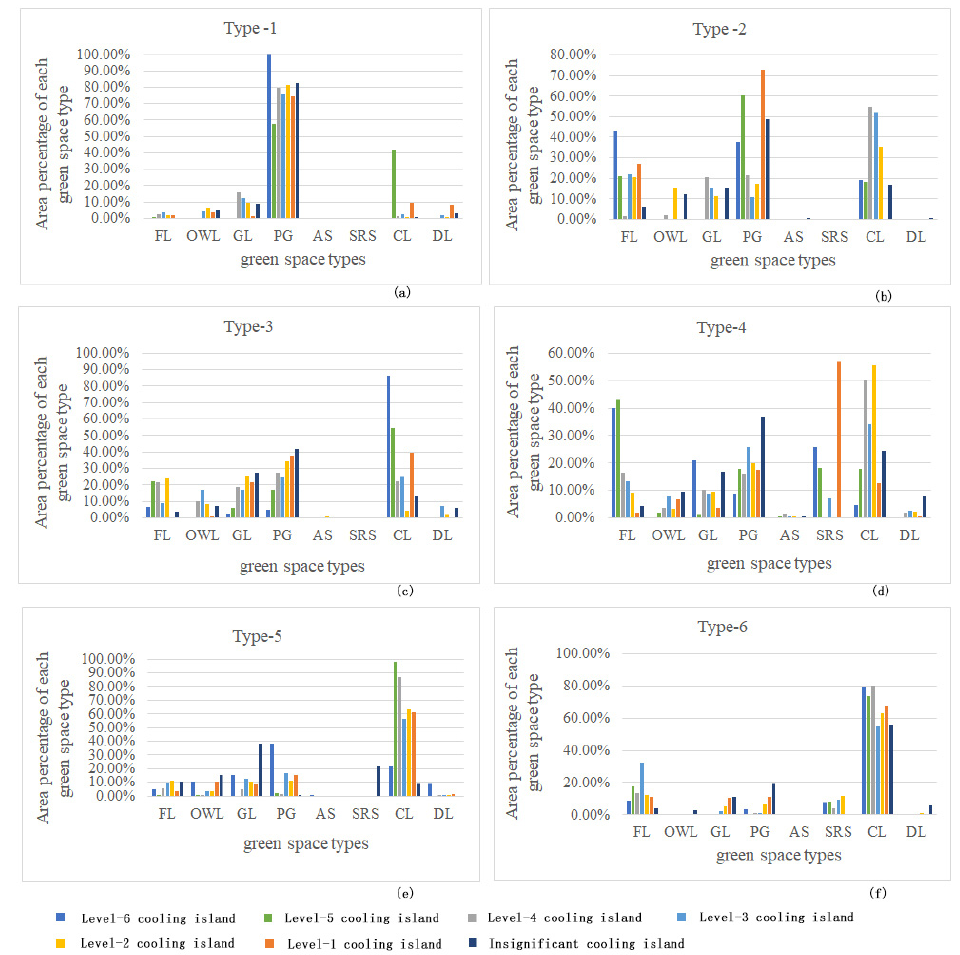
Figure 11. Area percentage of each greenspace type in the CI area with six different river types. ( a ) Type -1 rivers; ( b ) Type-2 rivers; ( c ) Type-3 rivers; ( d ) Type-4 rivers; ( e ) Type-5 rivers; ( f ) Type-6 rivers. Note: ① in the composition of the one cooling island level which was represented by each color column, the sum of the area proportions of all greenspace types (FL, OWL, GL, PG, AS, SRS, CL, and DL) is 100%. Observing the same color column, it can be seen which greenspace type constitutes the main body of this cooling island intensity grade; ② the various color columns of each type of greenspace indicate that the greenspace type has a different proportion of cooling island area. The closer the color column is to 100%, the more it reflects that the main cooling range of this greenspace type is located at the intensity level of the cooling island represented by the corresponding